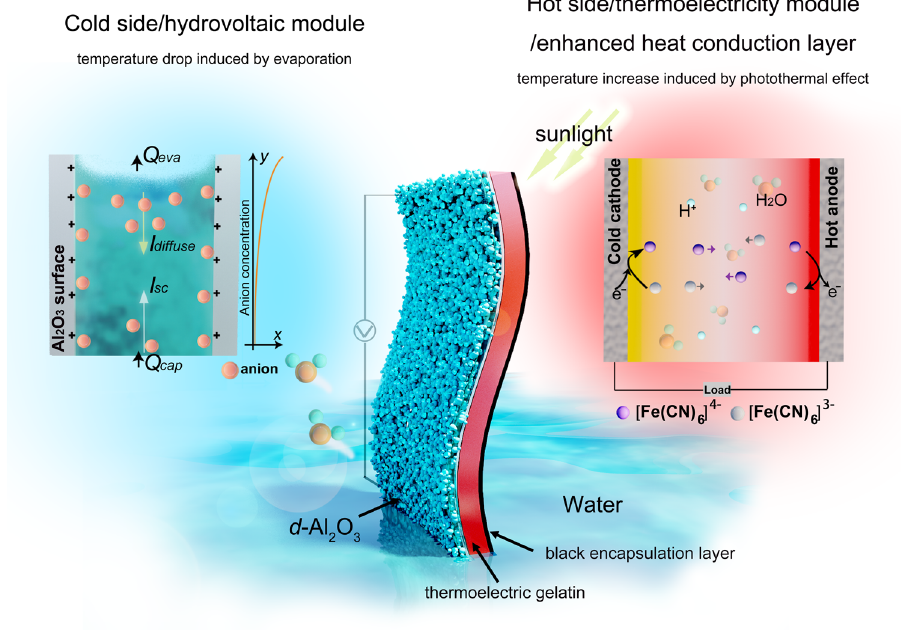
Fig. 1 Schematic diagram of the HCEHG. Schematic diagram of the structure and mechanism of the HCEHG for sustained evaporation electricity output and thermoelectric conversation without any special environmental